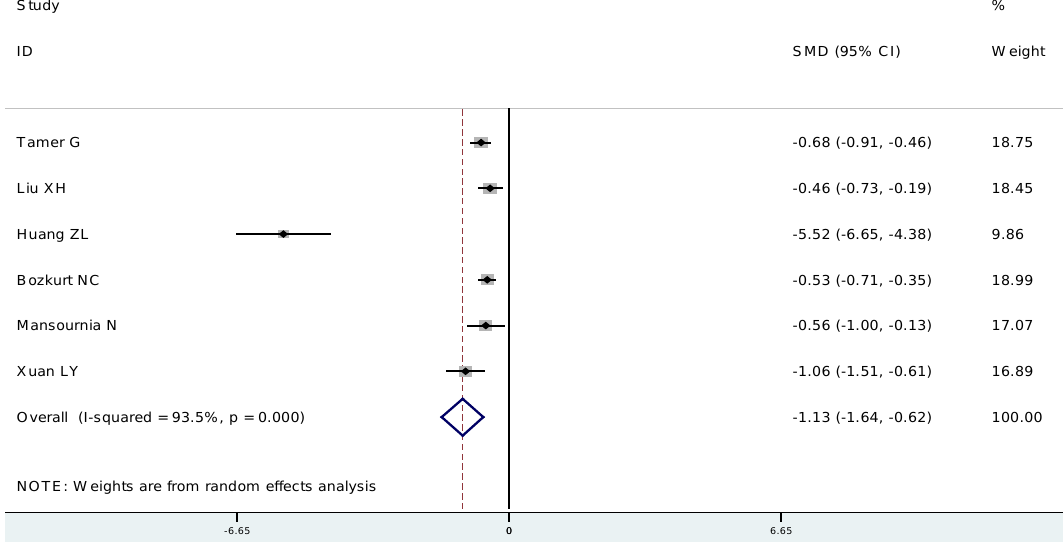
Figure 6. Meta-analysis of studies (chronologically ordered) reporting 25(OH)D levels in Hashimoto thyroiditis vs. controls, standardized mean difference with 95% confidence interval.